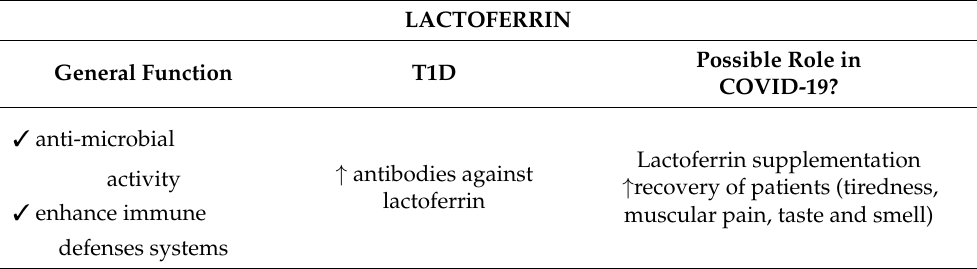
Table 3. Evidences related to lactoferrin’s role in T1D, and its possible association with COVID-19.